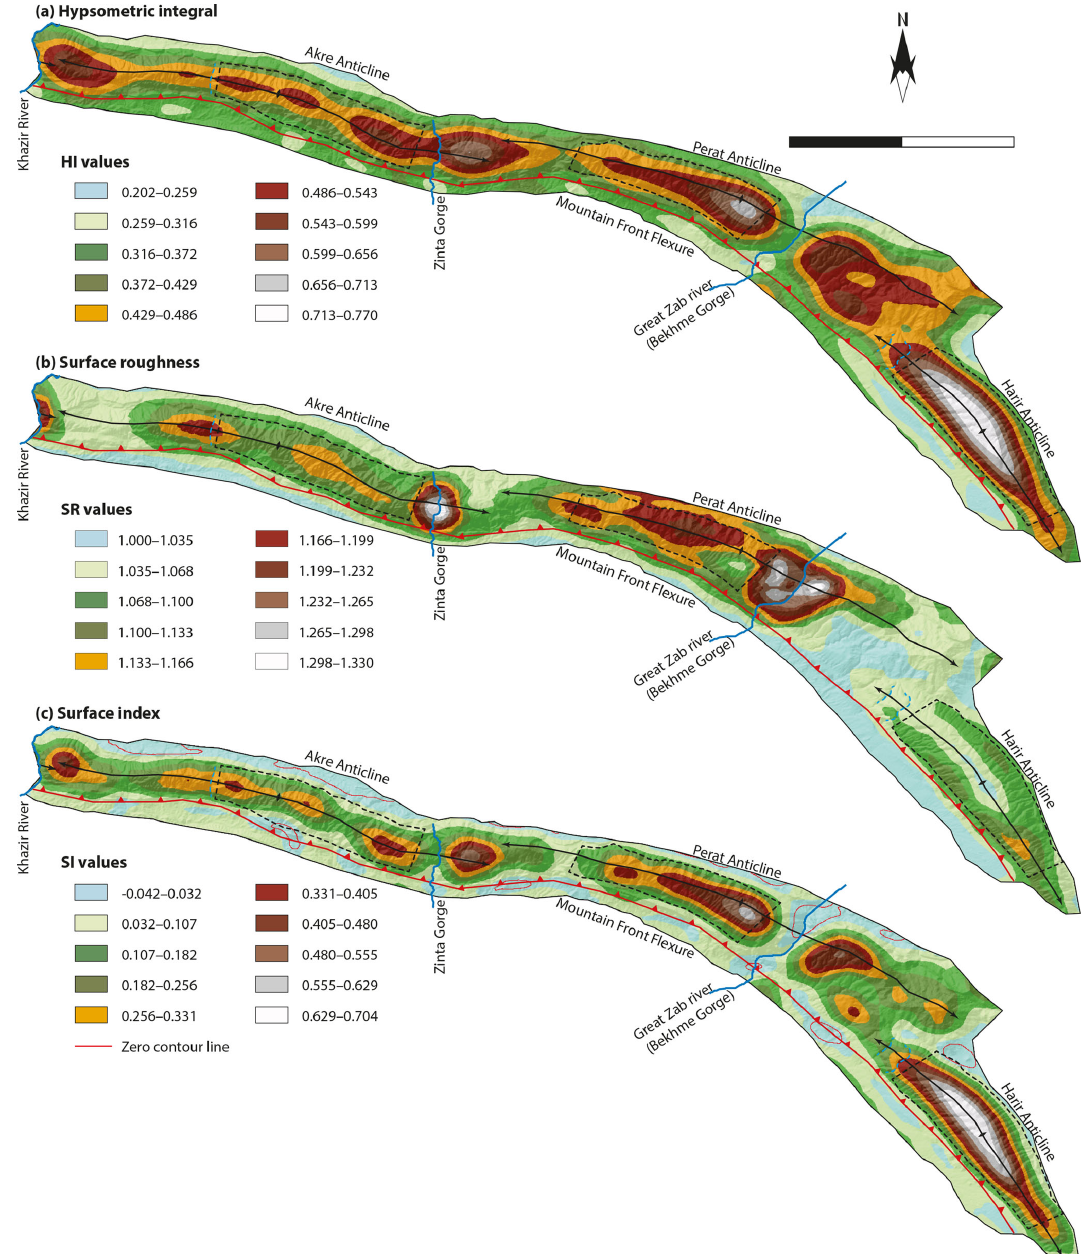
Figure 7. Surface index maps for the three anticlines calculated from 100 × 100 cell (3km × 3km) and moving windows; (a) hypsometric integral, (b) surface roughness, and (c) surface